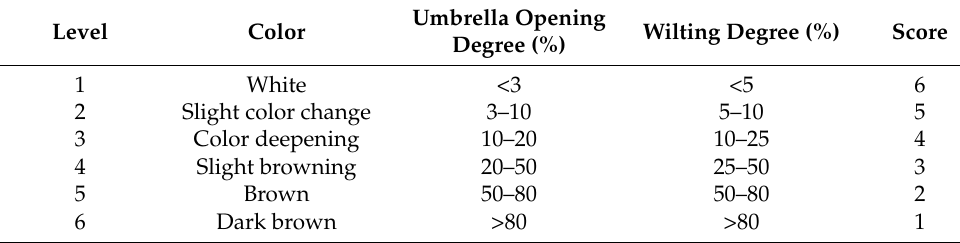
Table 1. The sensory evaluation standards for button mushrooms during